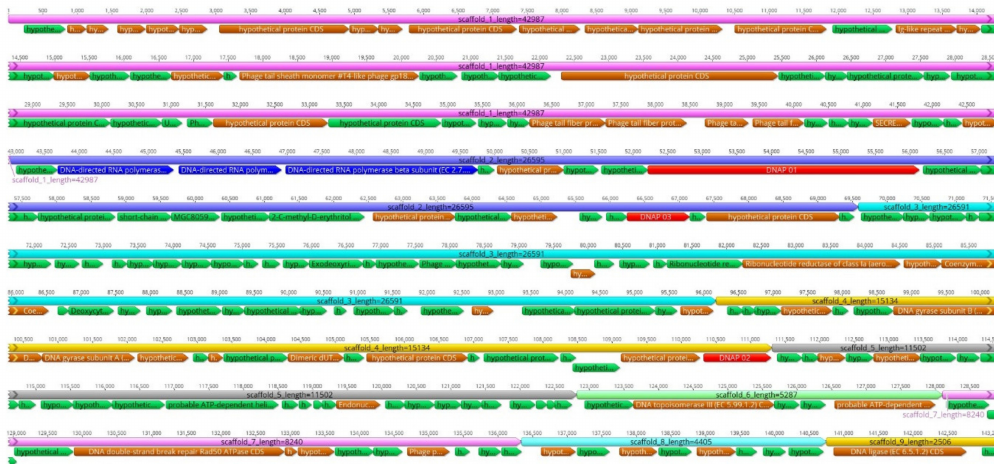
Figure 2. Gene organization of the nine sca ff olds of the phage YerA41 genome. The sca ff olds are organized based on size. The gene colors indicate predicted functions of their products: Green, hypothetical proteins; Blue, RNA polymerase subunits; Red, DNA polymerase-like proteins; Brown, phage particle associated (structural) proteins. The figure was generated using Geneious 10.2.6 (www.geneious.com). Table 2. The assembled sca ff olds of YerA41 genome. The numbering of the sca ff olds is based on their length and does not reflect their actual position in the phage genome. ID Size [bp] GC% sca ff